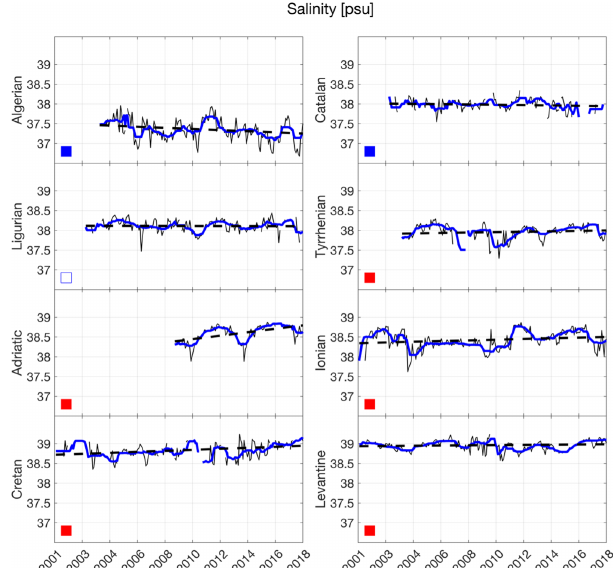
Figure 3. AW salinity time series in eight sub-basins: the thin black lines show the monthly time series (seasonal cycle filtered out), the thick blue lines are the 1-year moving average time series, and the dashed black lines are the trends. The filled red and blue squares identify the positive and negative trends with p value ≤ 0.05, re- spectively, while the unfilled red and blue squares identify the posi- tive and negative trends with p value > 0.05,